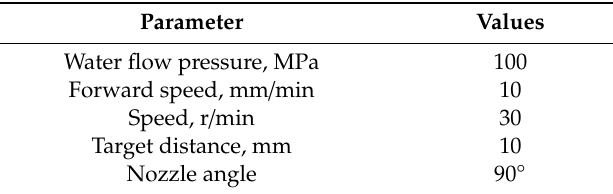
Table 3. Parameters of waterjet peening progress.